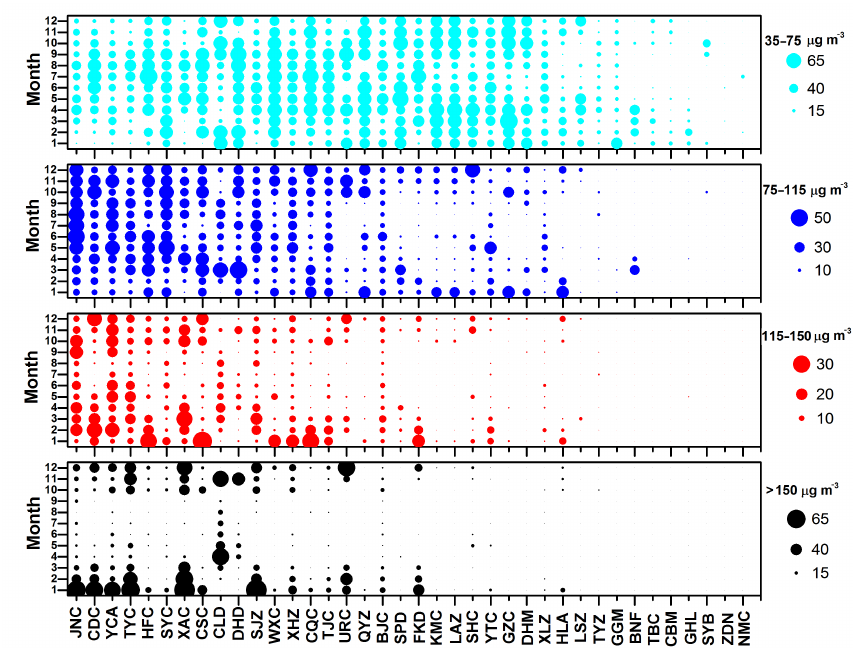
Figure 7. Monthly distribution of the occurrence of the polluted days exceeding the Ambient Air Quality Standard (AAQS) (GB3095-2012) of China. The symbol size represents the occurrences of polluted days for the corresponding month. The coloured circles represent the different mass ranges. The sites of Nagri and Mount Everest are excluded because of the small sample size. The site codes related to the observation stations can be found in Table